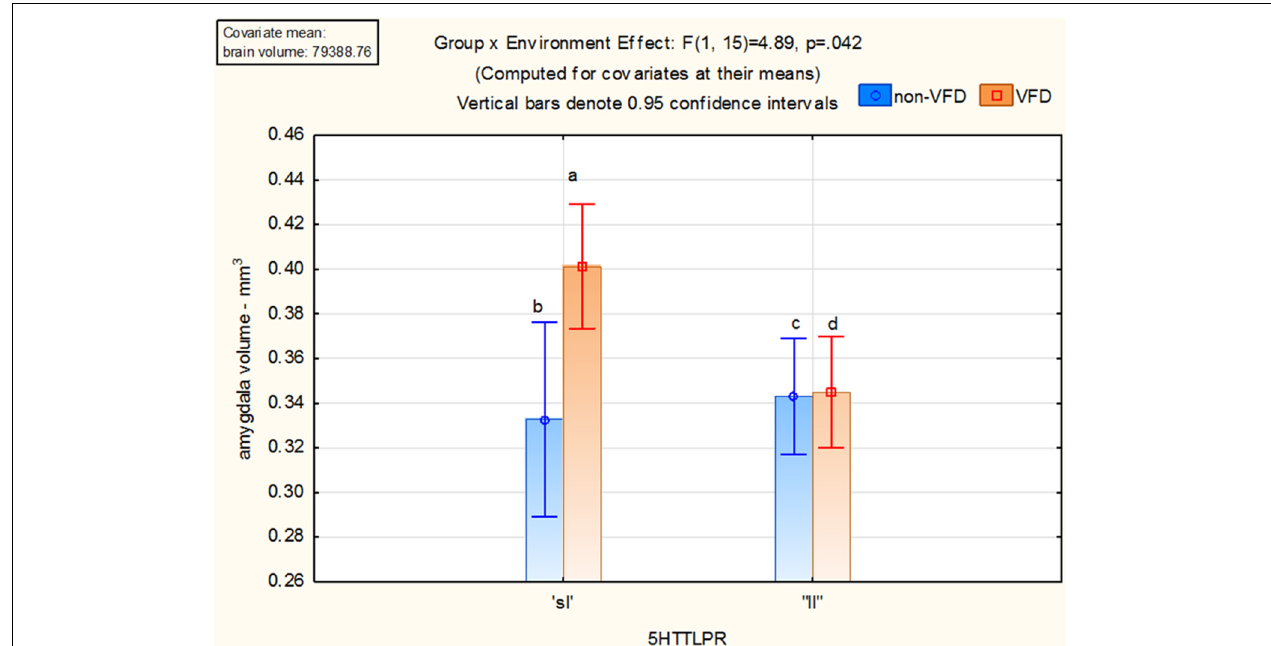
FIGURE 3 | Gene × environment effect for amygdala volume in adversely-reared macaques possessing the short allele of the serotonin transporter gene. Using the GLM factorial design, a group effect for overall amygdala volume was noted [ F (1 , 15) = 5 . 65; p = 0 . 031] but no significant allele effect. A gene by environment effect [ F (1 , 15) = 4 . 89; p = 0 . 042] was noted. Using Fisher least-square differences post-hoc testing, VFD-reared